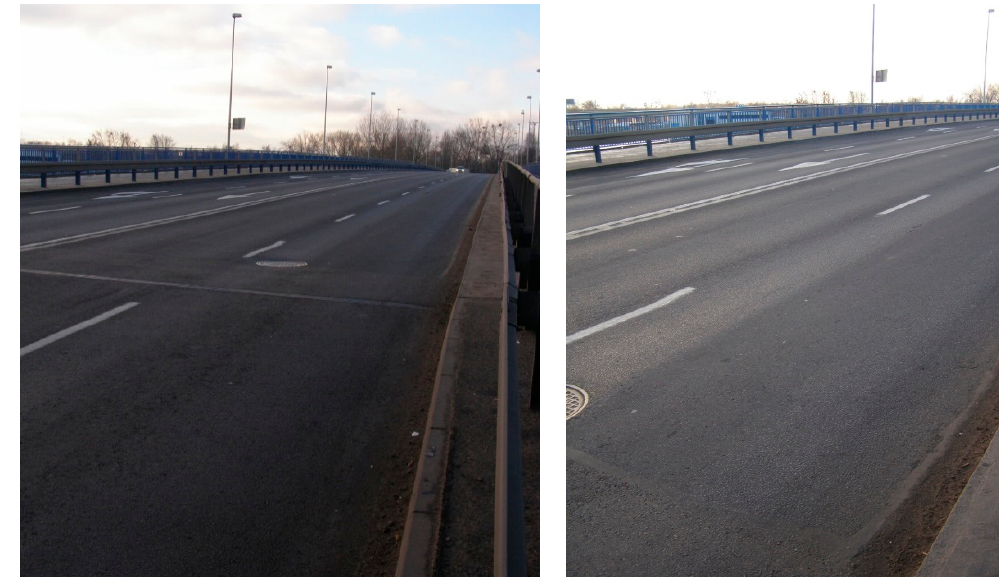
Figure 8. Current condition of pavement with the protective layer made of stone mastic asphalt (SMA) 5 mixture with increased content of bitumen mastic on the overpass supporting Mickiewicza St. in Szczecin (year of completion: 2001).